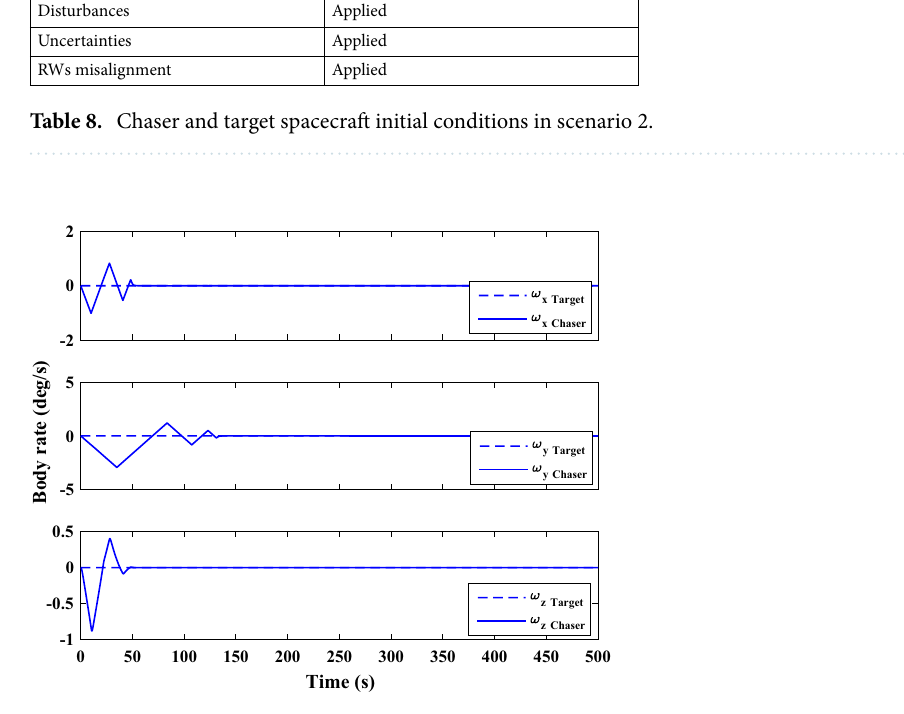
Figure 33. Scenario II: angular velocity